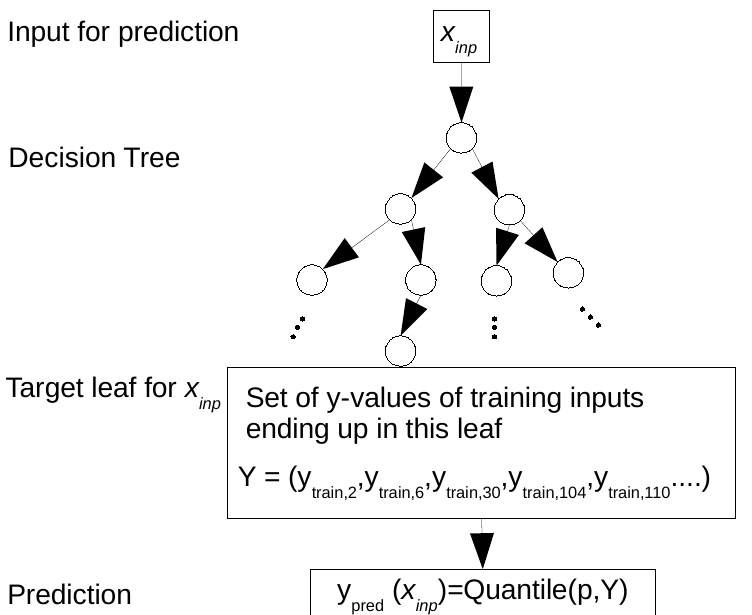
Figure 5. Illustration of how a single tree of a (trained) QRF is used to make a prediction. The decision tree is used to choose the leaf node that corresponds to the input via applying the learned decision rules. The leaf node contains the set of y (prediction) values of all training samples that would end up in this leaf node when predicting on the training data; here, an example of training sample 2, 6, 30, 104, and 110 ending up in the node is shown. The prediction value for the input is the desired quantile of this set. In a normal regression tree, the mean value of the set of y-values is used as prediction. In order to predict with the whole forest, each decision tree is parsed separately, and then a weighted quantile over all y-values in all the chosen leaf-nodes is